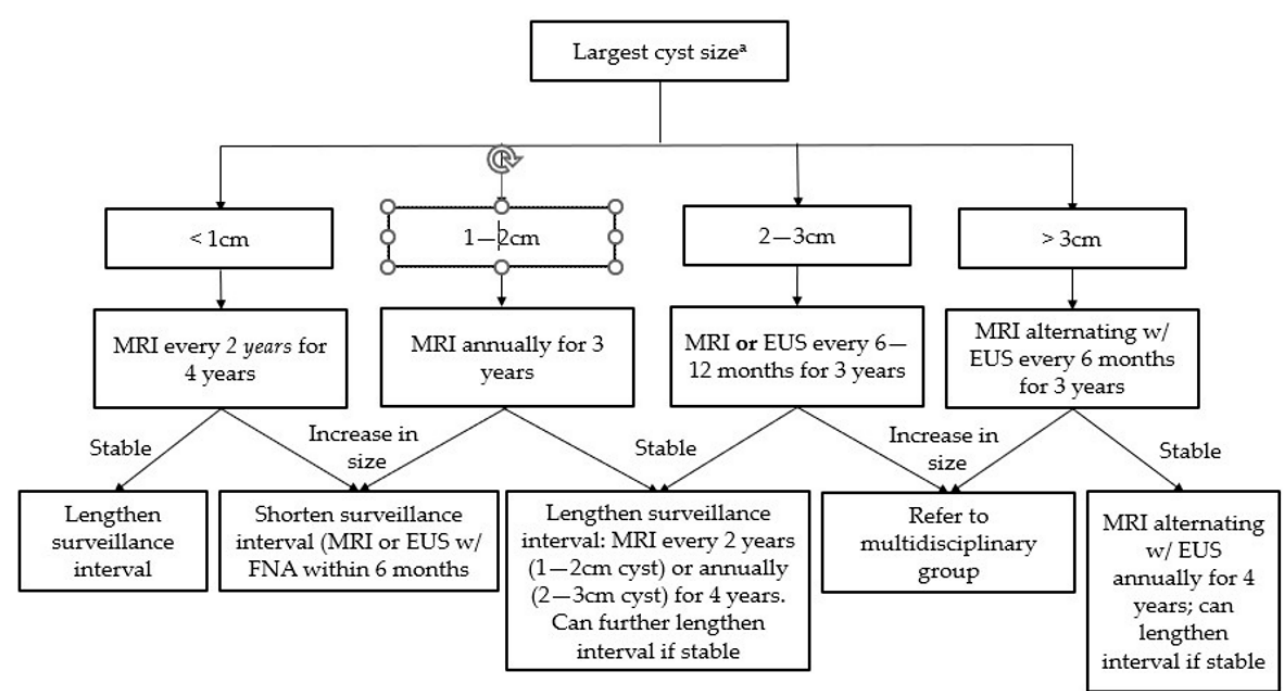
Figure 3. Surveillance guidelines for mucinous pancreatic cysts (Adapted from the 2018 ACG Clinical Guideline: Diagnosis and Management of Pancreatic Cysts). a Size-based surveillance guidelines only apply in the absence of high-risk features (see Table 1)